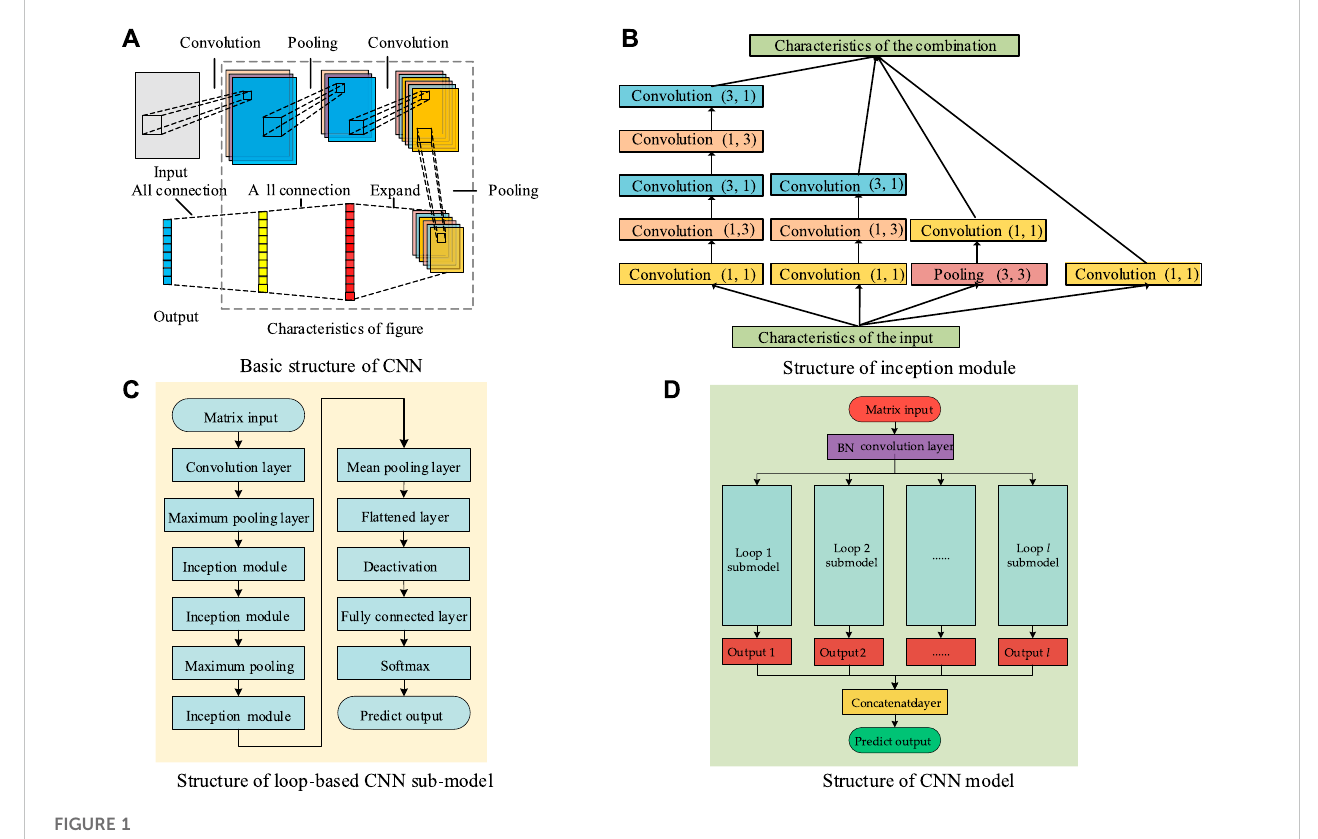
FIGURE 1 Basic structure of CNN